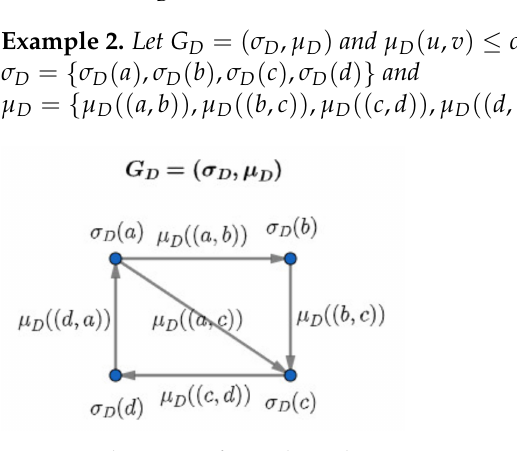
is a directed graph. D